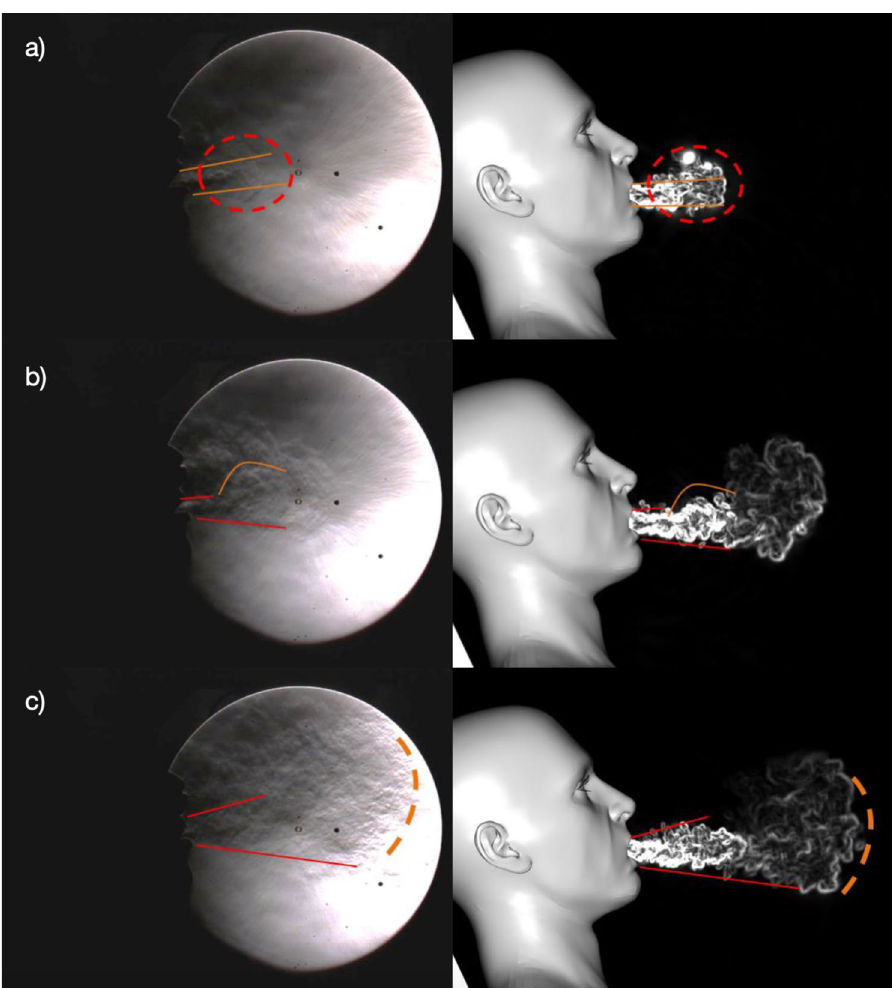
Figure 3. Air density gradient visualization of a volunteer’s cough with HFNC at 60 L/min taken from the schlieren images (left) and the associated numerical simulations (right): ( a ) at t = 65 ms; ( b ) at t = 150 ms; ( c ) at t = 190 ms. A good correlation is observed between the experiment and the simulation for the front and the bottom part of the jet. Leaks coming from the nose can explain the differences observed for the upper part of the